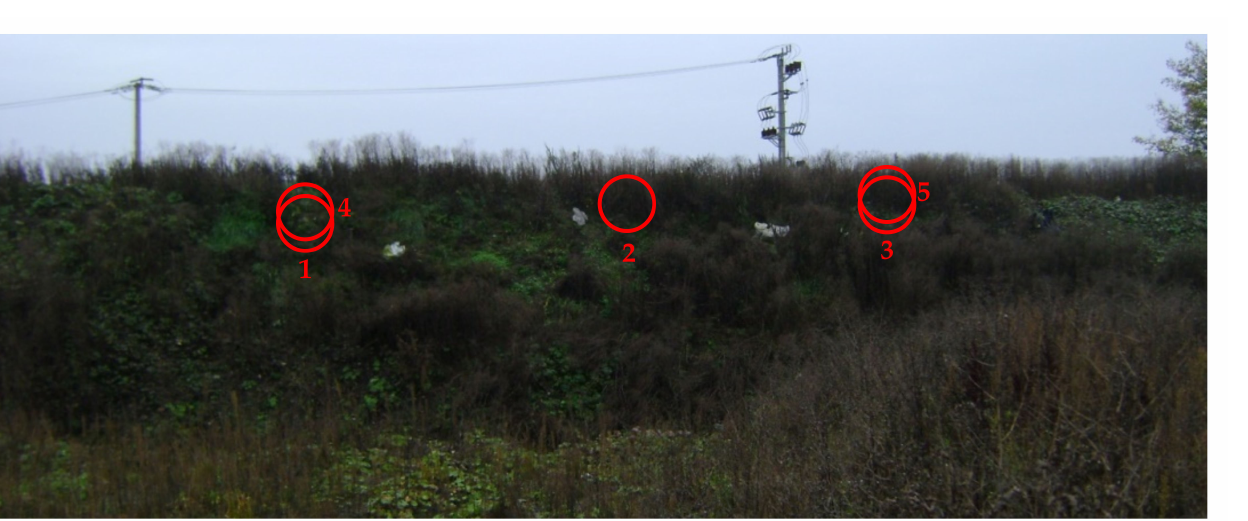
Figure 2. General view of the protected slope in Nieboczowy (numbers mark soil sample locations and state of slope